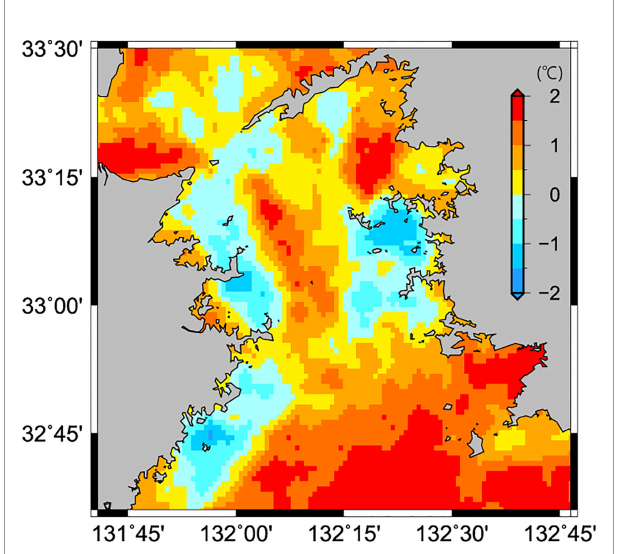
FIGURE 4 | Sea surface temperature (SST) difference between July 10 and 15. Negative values denote a water temperature decrease from July 10.